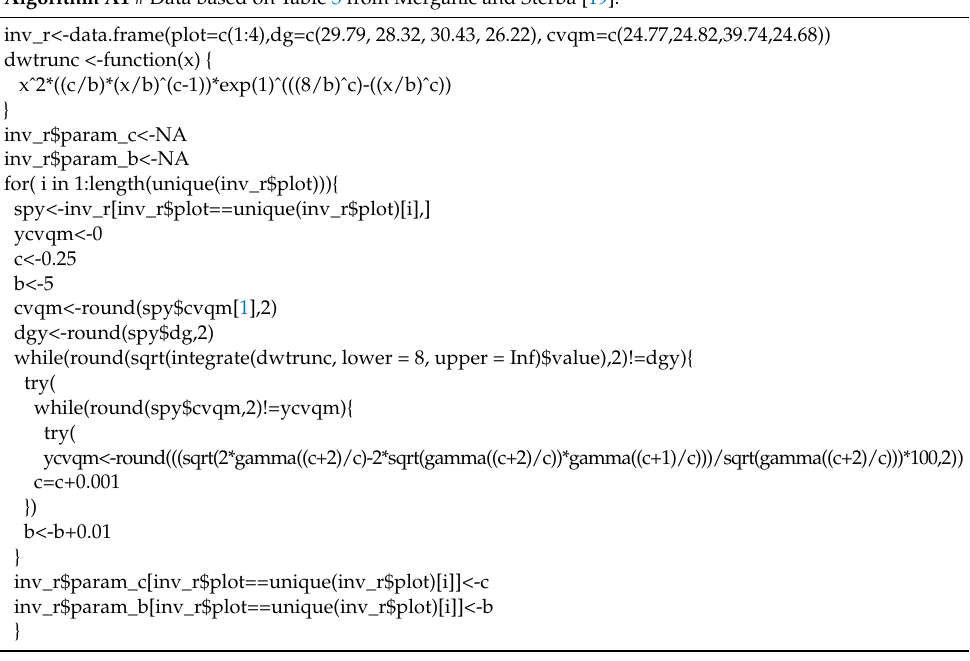
Algorithm A1 # Data based on Table 3 from Merganiˇc and Sterba